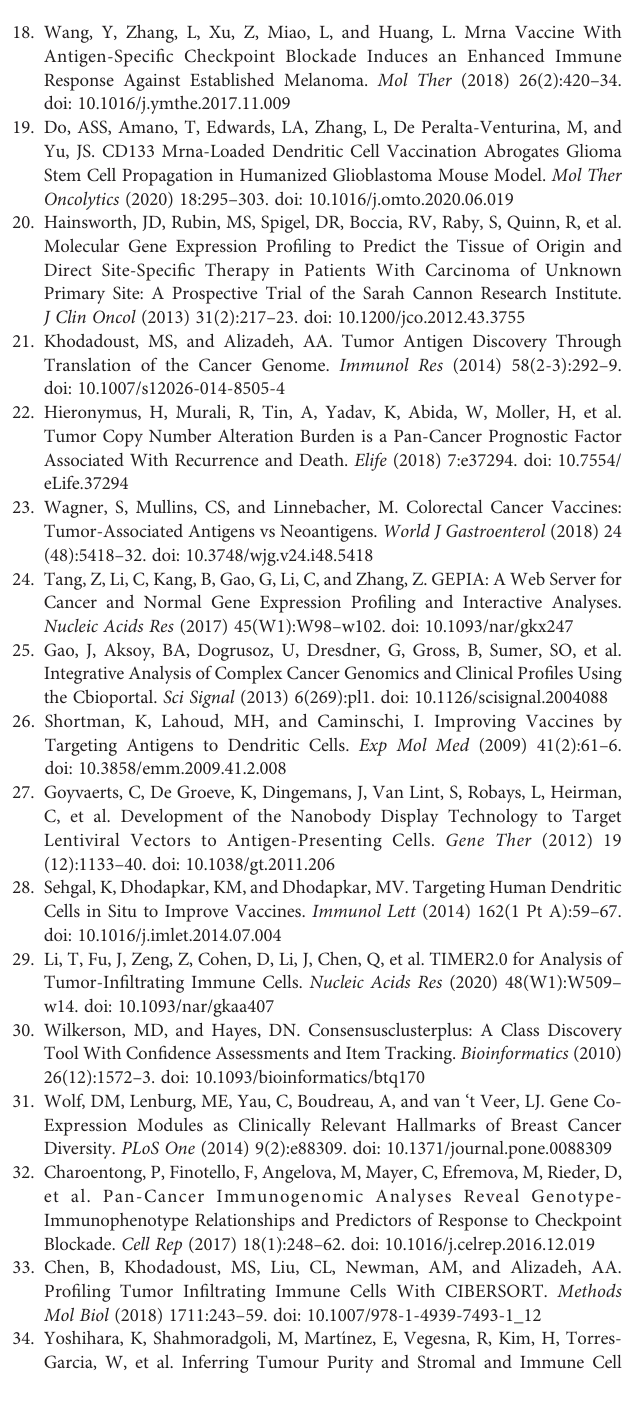
Supplementary Figure 3 | Association between immune subtypes and TMB and mutation. (A) Ten highly mutated genes in GBM immune subtypes. (B) mutation number and (C) TMB in GBM IS1-IS3. * p < 0.05. Supplementary Figure 4 | Association between immune subtypes and immune moleculesand immunecellssignatures. Differential expressionof (A) ICP genesand (B) ICD genes among the GBM immune subtypes. (C) Differential enrichment scores of 28 immune cell signatures in the above subsets. * p < 0.05, ** p < 0.01, *** p <